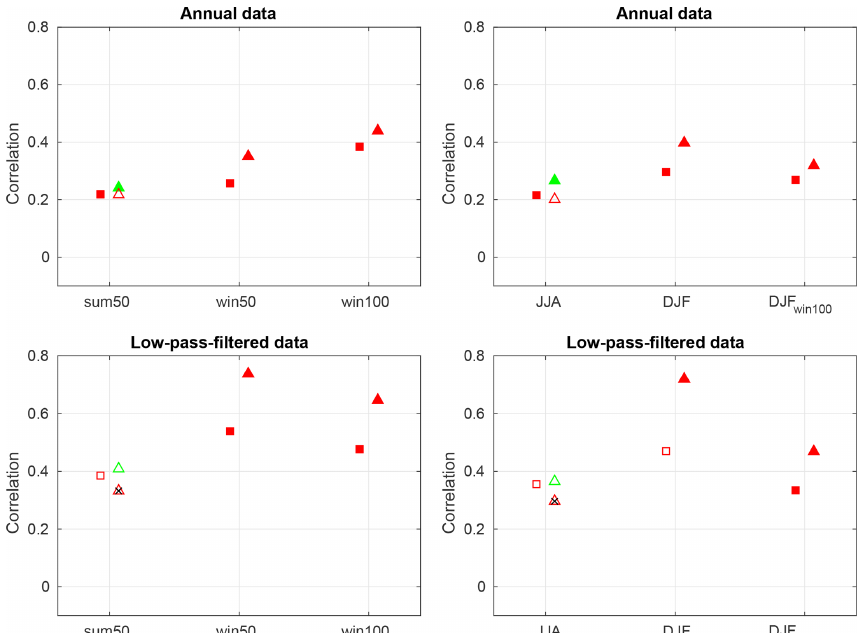
Figure 10. Correlation analysis of the North Atlantic SST index (50–70 ◦ N, 70–0 ◦ W) for reconstructions using eight ice cores (triangles) and 19 ice cores (squares) correlated with COBE SSTs covering 1851–1970. The green markers are for the reconstructions including tree-ring data. Open markers indicate significance of p < 0 . 1, and full markers indicate p < 0 . 05, while crossed-out markers indicate p > 0 .